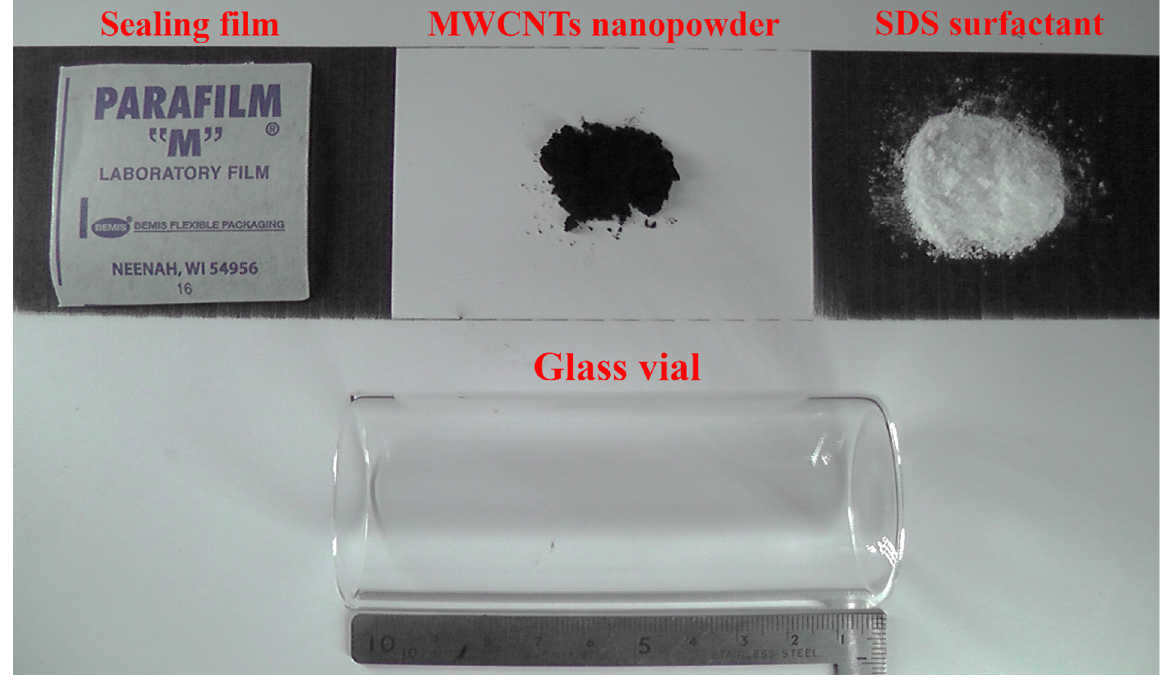
Figure 1. Nanofluids starting materials, which includes the sealing film, MWCNTs nanopowder, SDS surfactant, and glass vial.